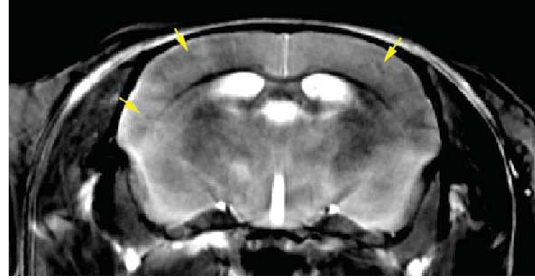
Fig. 10. In vivo imaging of the mouse brain after Gd-DTPA deliv- ery in conjunction with ultrasound opening of BBB. (TR=400ms, ETL=8 echoes, echo spacing 6.4ms, resolution 40 × 52 × 625 (cid:1) m, matrix size of 512 × 512 × 32 slices, BW 62.5kHz. Total acquisi- tion time is under 2 hours. Note the reduced signal from the plaques (arrows). (Colours are visible in the online version of the article;